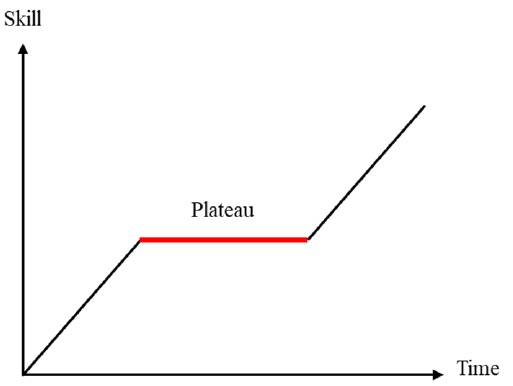
Figure 3. Learning plateau.